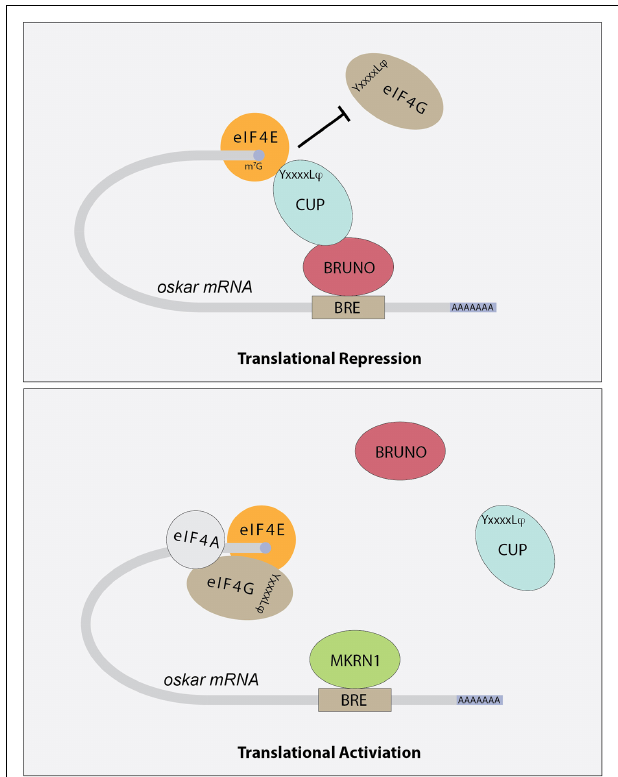
FIGURE 3 | Schematic showing how different factors contribute to the regulation of oskar mRNA translation. Bruno binds to Bruno Response Elements (BREs) in the 3 (cid:48) UTR of target mRNAs, including oskar . Bruno associates with Cup protein, which in turns binds to eIF4E, preventing the recruitment of eIF4G and effectively blocking translation initiation. The YxxxxL ϕ (where x is any amino acid and ϕ is a hydrophobic amino acid) motif is indicated. Other mRNA binding proteins, including Mkrn1, compete with Bruno for binding. Once these proteins displace Bruno and Cup, translation initiation can